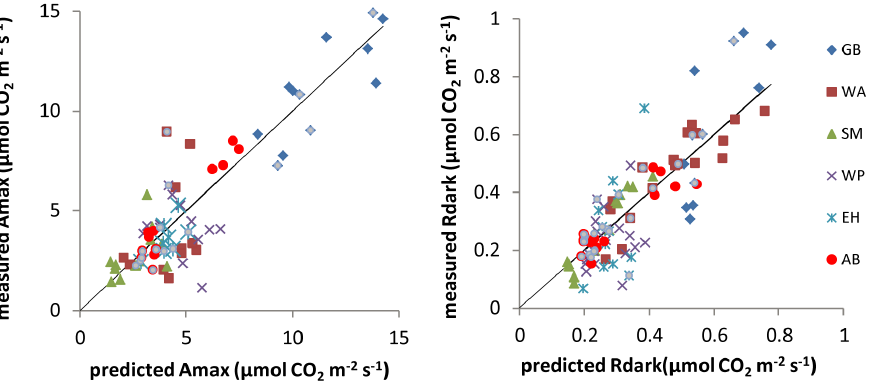
Figure 5. Predicted per-area leaf photosynthetic capacity (Amax area ) and dark respiration rate (Rdark area ) vs. observed values. The model (Equation 2 in main text) assumes that each leaf’s Amax area (or Rdark area ) is equal to a species-specific constant per-mass Amax (or Rdark) times the leaf’s mass:area ratio (LMA). Symbols marked by small grey dots indicate shade leaves of sun grown trees. Species code: GB=gray birch, WA=white ash, SM=sugar maple, WP=white pine, EH=eastern hemlock, AB=American beech.